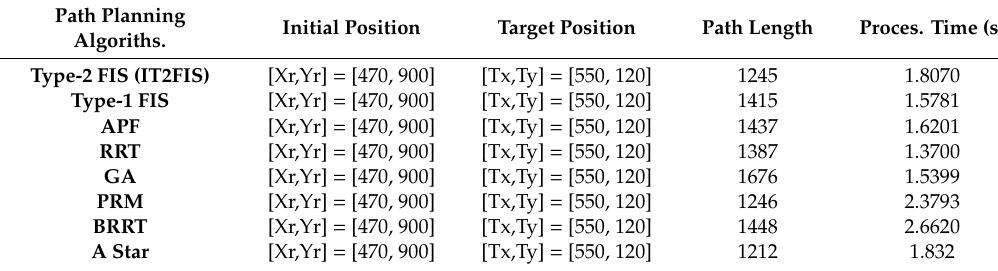
Table 2. Comparison values between mobile robot path planning algorithms used in our experiments. Path Planning